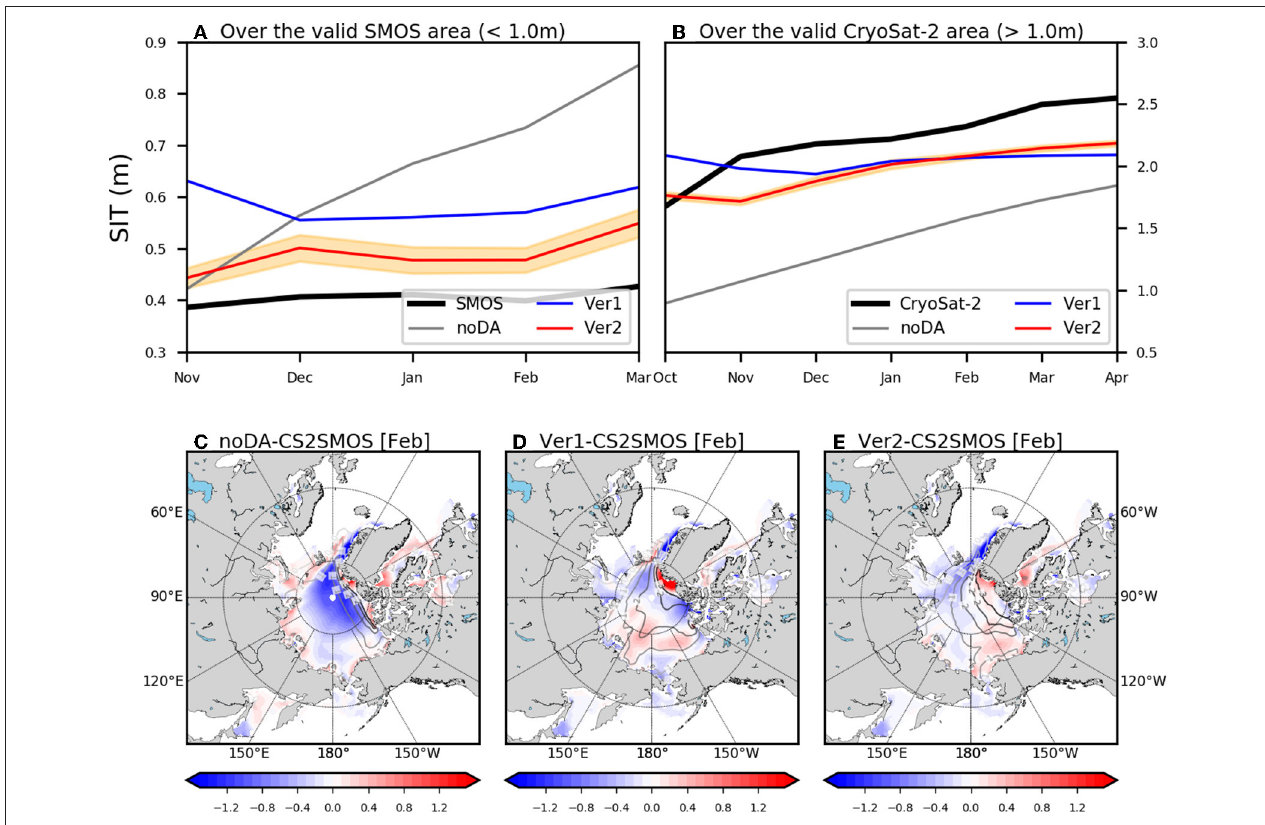
FIGURE 7 | The mean seasonal cycle of sea ice thickness (m) averaged over the valid SMOS area (A) and over the valid CryoSat-2 area (B) during 2011–2019 for satellite observation used for assimilation (black), noDA experiment (gray), Ver1 (blue), and Ver2 (red). The orange shading in (A,B) marks the uncertainty (standard deviation) of the analysis. The climatological bias in noDA (C) , Ver1 (D) , and Ver2 (E) with respect to CS2SMOS in February. The contour lines in (C–E) represent the climatology in each model